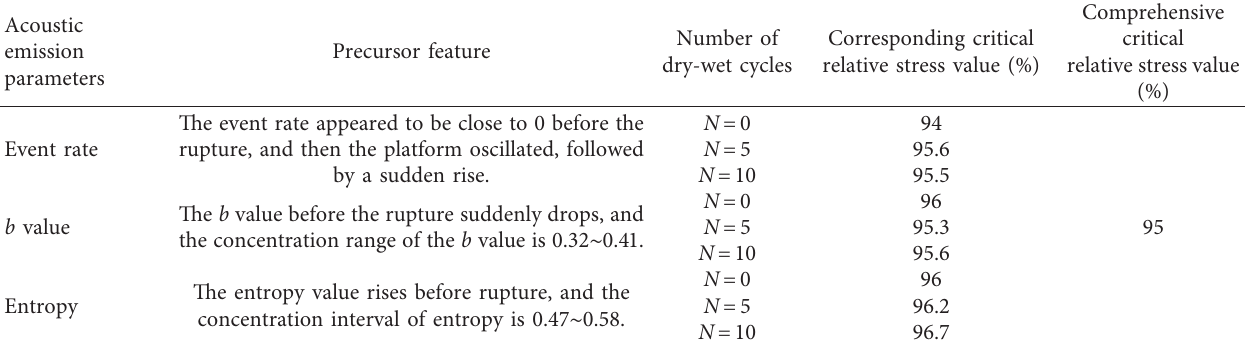
Table 2: Acoustic emission parameter information during the destruction of weakly cemented